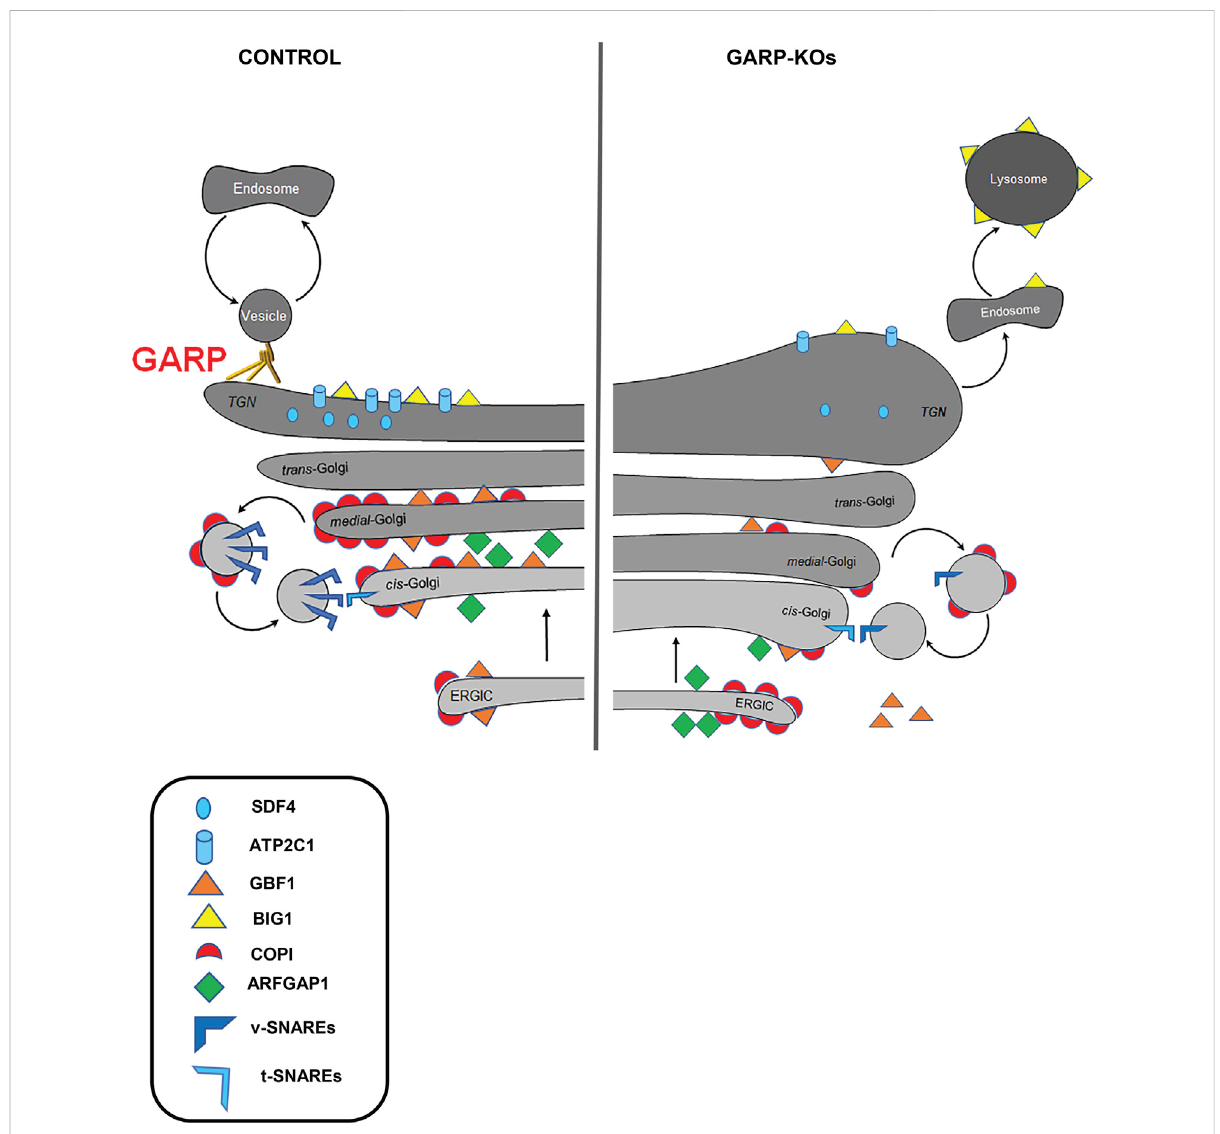
FIGURE 12 GARPdysfunctionaltersGolgihomeostasisandGolgitraf fi ckingmachineries.AcartoondepictingGolgitraf fi ckingmachineryinWTandGARP- KOcells.PropermaintenanceofGolgistructure,calciumchannelandGolgitraf fi ckingmachineryincludingSNAREs,COPIcoats,ARFGEFsincontrol cells (Left panel). Disruption of the Golgi structure, calcium channel, and Golgi traf fi cking machineries in GARP-KO cells (right